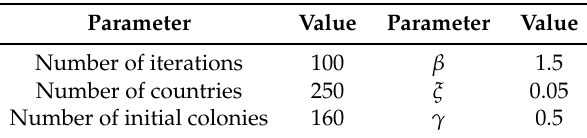
Table 2. Parameters of ICA